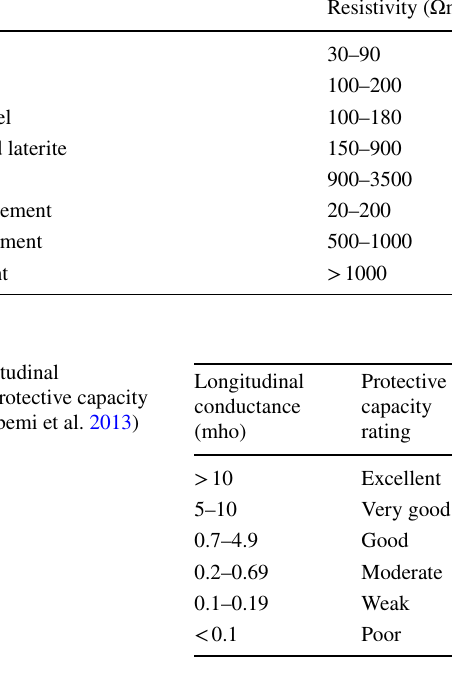
Table 1 Resistivity values of rock types (Ajayi and Hassan 1990) Rock Type